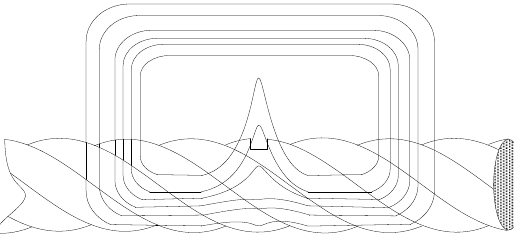
Figure 1. Magnetic circuit of a defect in a wire rope.